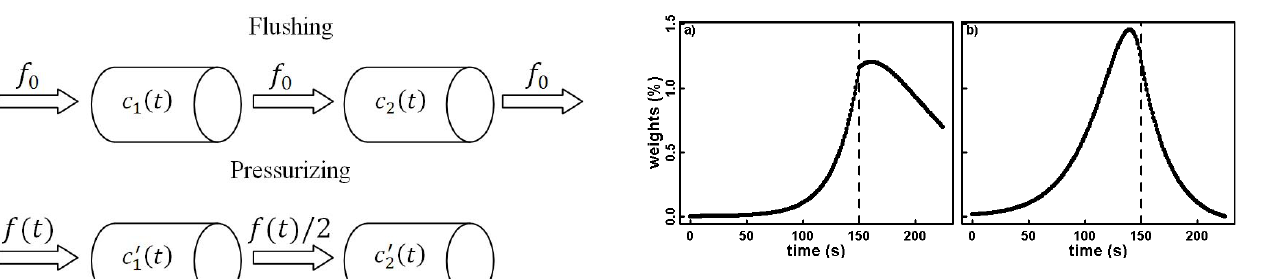
Fig. 7. Weighting functions for integrating in situ measurements to compare them with pair-flask measurements, plotted as a function of time: (a) for the upstream flask and (b) for the downstream flask, respectively. The time scale is relative to a chosen time (150s for paired flask) prior to the start of pressurizing. The weights are given in percentages. The dashed lines denote the time when the pressur- izing period starts. The weighting functions are calculated based on the recorded and smoothed flask